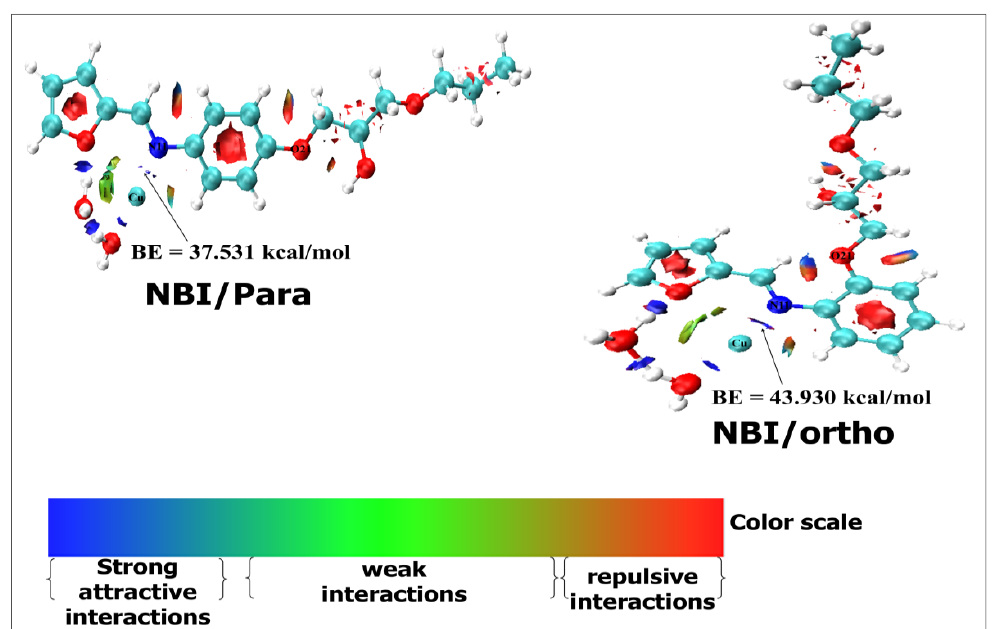
Figure 15. NBI analysis of two complexes: H 2 O-Cu-N11(Si-p-OR), noted NBI/para, and H 2 O-Cu-N11(Si-o-OR), noted NBI/ortho.